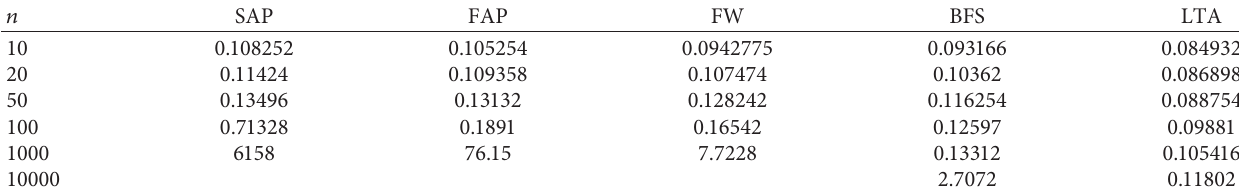
Table 1: Computing time (milliseconds) of five algorithms for star